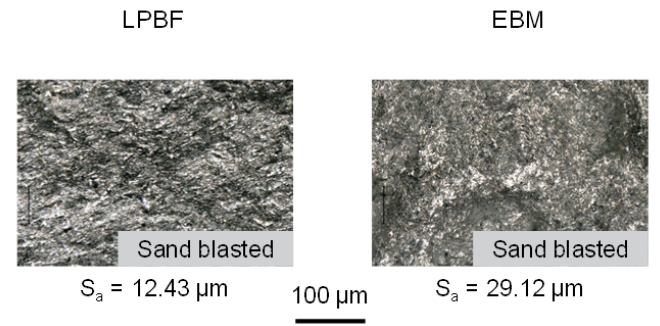
Figure 9. Images of sand blasted LPBF and EBM surfaces.